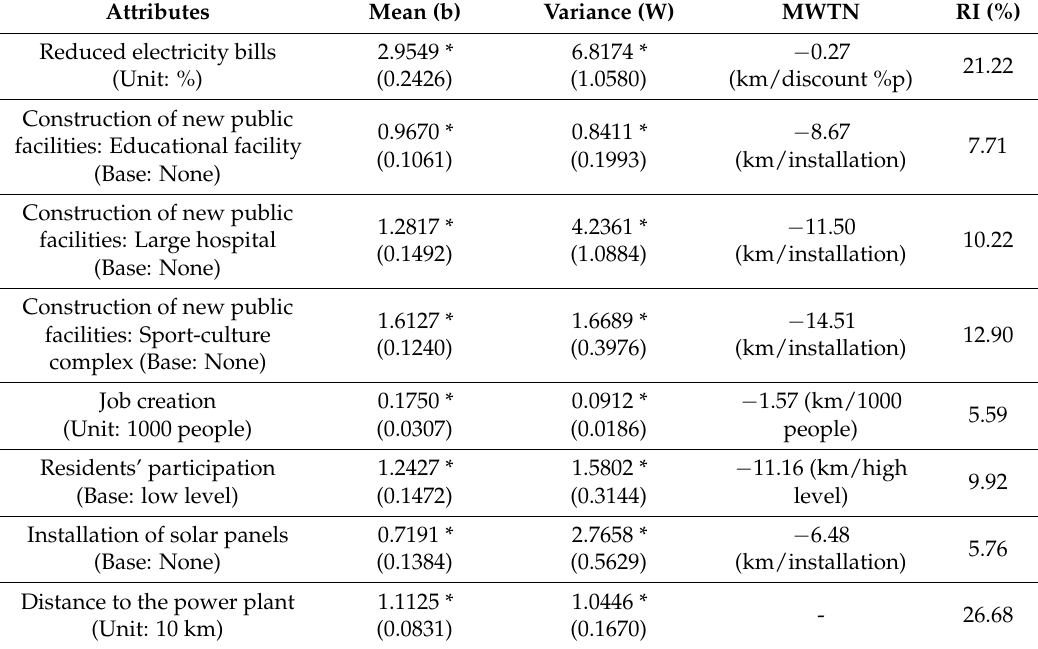
Table 3. Estimation based on the mixed logit model: Social preferences for incentives for hosting a new nuclear power